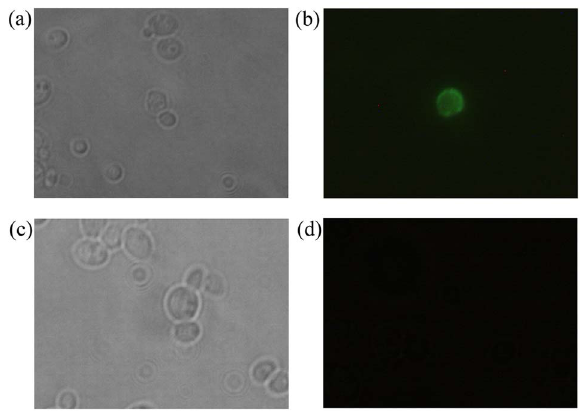
Figure 3. Fluorescence microscopy assay of recombinant P. pastoris cells displaying Bm AChE: The fluorescence at 519 nm emitted with excitation at 495 nm was observed by fluores- cence microscopy. (a) and (c), phase micrographs of recombinant yeast cells; (b) and (d), fluorescent micrographs of recombinant yeast cells. GS115/pPIC9K- bmace-AG a 1 (a, b); GS115 as a control (c, d).